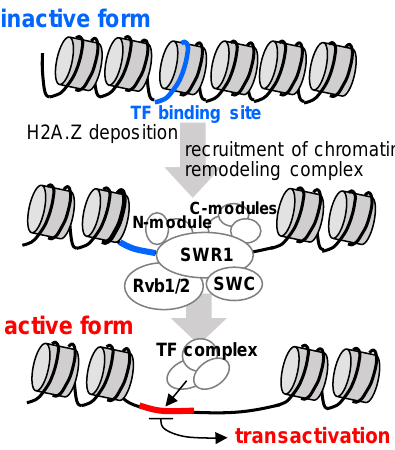
Figure 3. Overview of chromatin remodeling following H2A.Z deposition. N-module and C-module indicate histone and H2A.Z bindings.